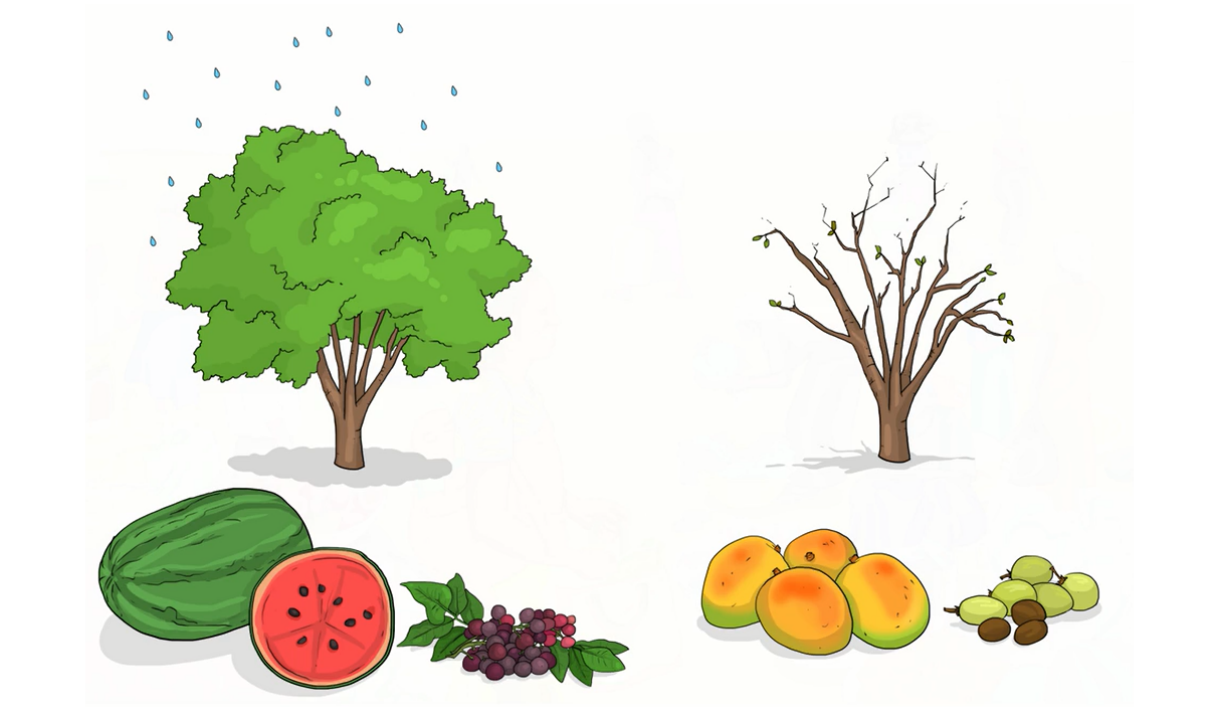
Figure 11. Seasons after